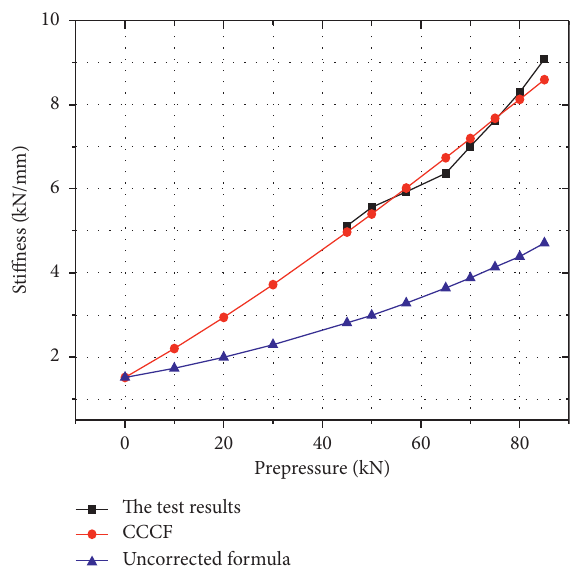
Figure 9: Comparison curves of different